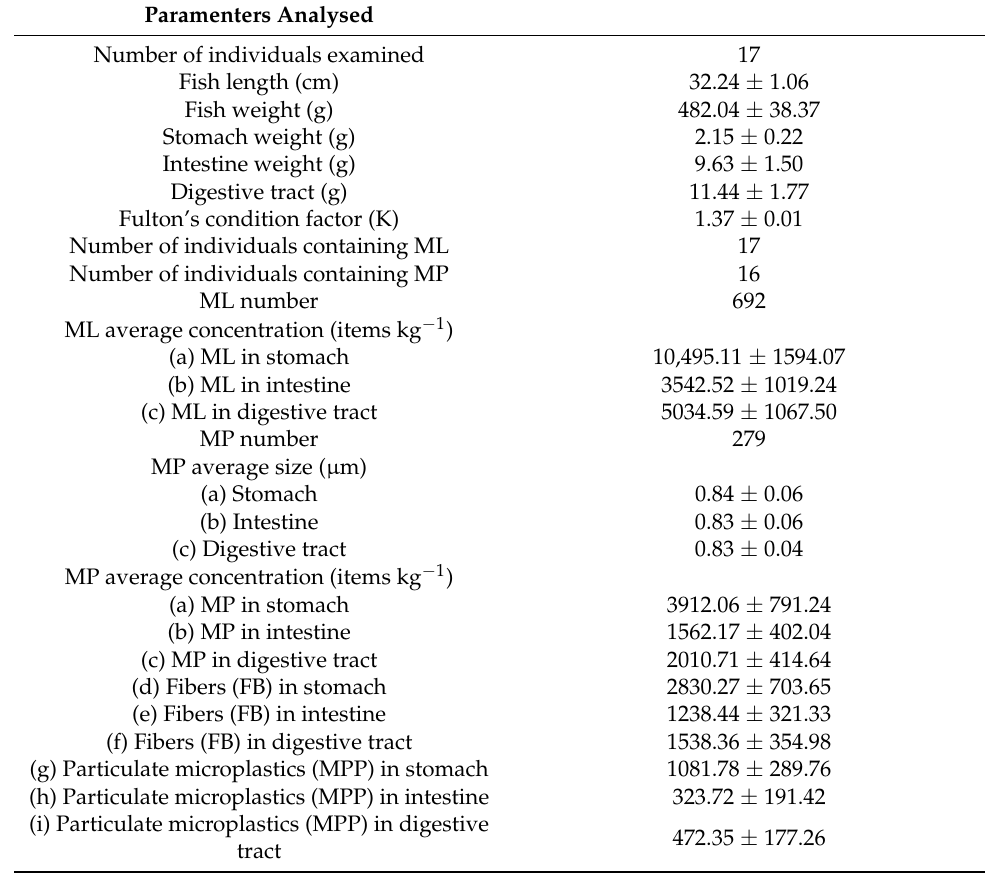
Table 1. Average values ( ± standard error) of diferent parameters analysed in commercial gilthead seabream (CGS). (ML: microlitter, MP: microplastics, FB: fibers; MPP: particulate microplastics). Paramenters